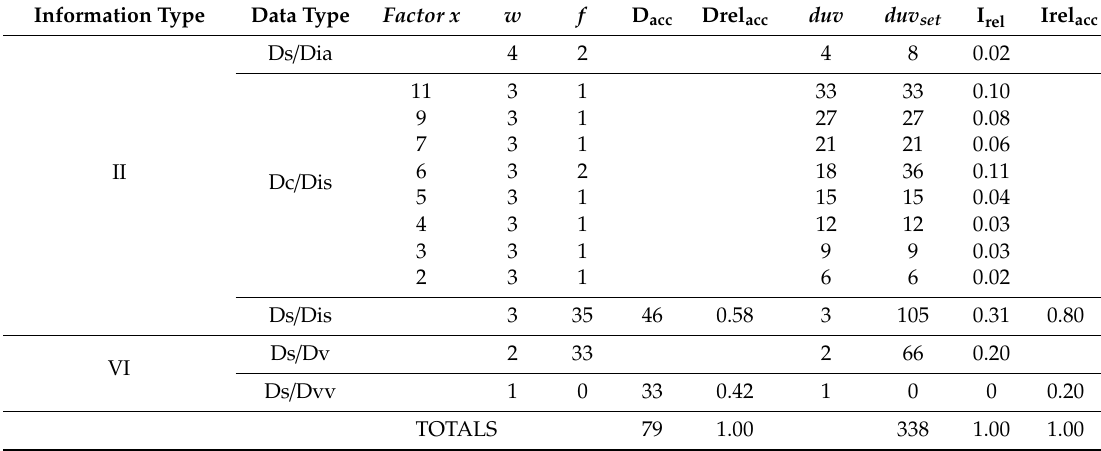
Table 6. Data classification and its transformation into information for the form